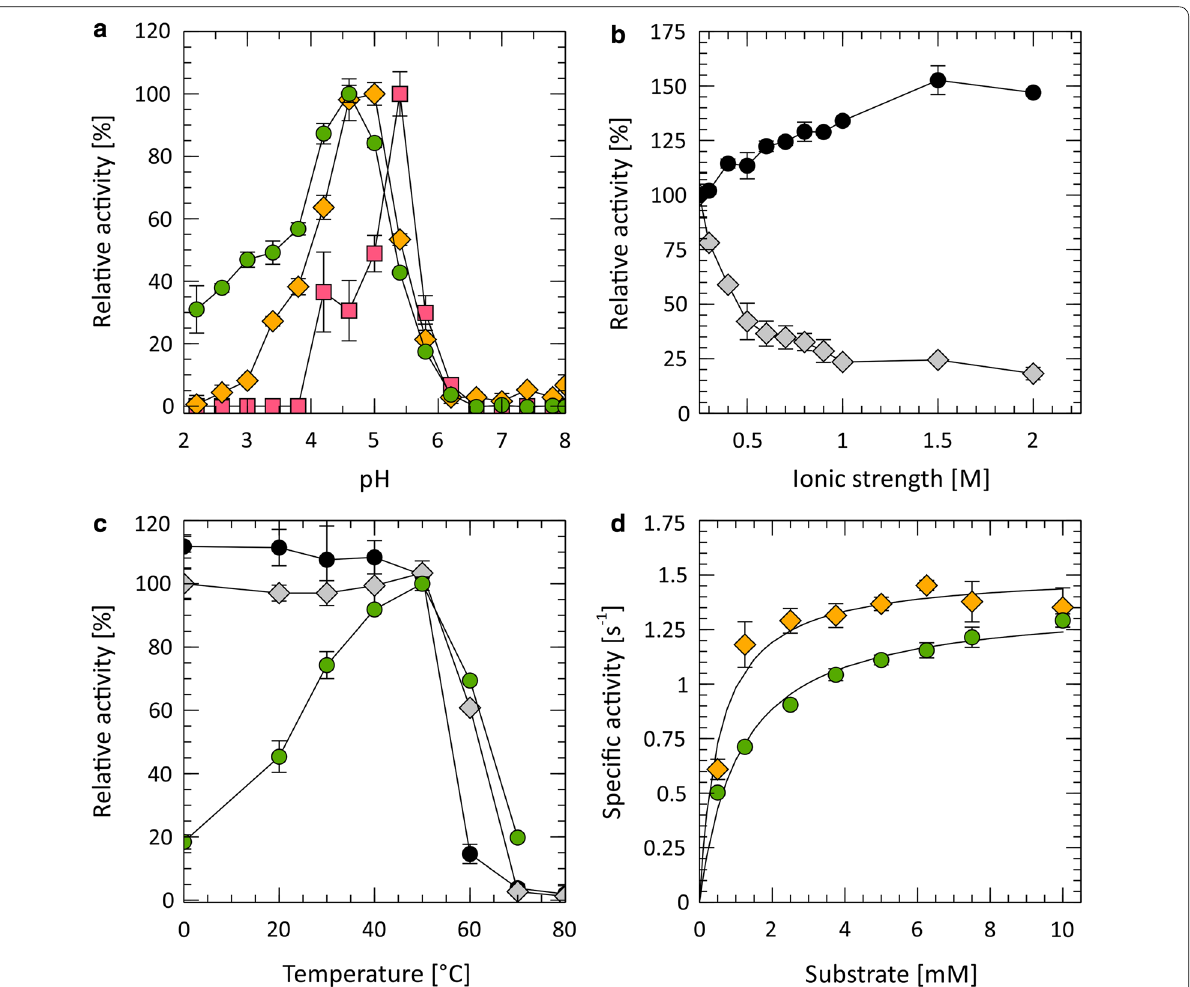
Fig. 5 a Effect of pH on the activity of purified Tvlcc5 with ABTS (green circle), 2,6-DMP (yellow diamond), and SGZ (pink square) as substrate. Activity was calculated in relation to the maximum value for each substrate. b Influence of ionic strength on the activity of purified Tvlcc5. Ionic strength was adjusted using NaNO 3 (black circle) or NaCl (grey diamond). The activity in pure buffer without addition of any salt was set to 100%. c Effect of temperature (green circle) on the activity of Tvlcc5 and residual activity after incubation at various temperatures for 10 (grey diamond) and 60 min (black circle). d Influence of the concentration of ABTS (green circle) and 2,6-DMP (yellow diamond) on the specific activity of purified Tvlcc5